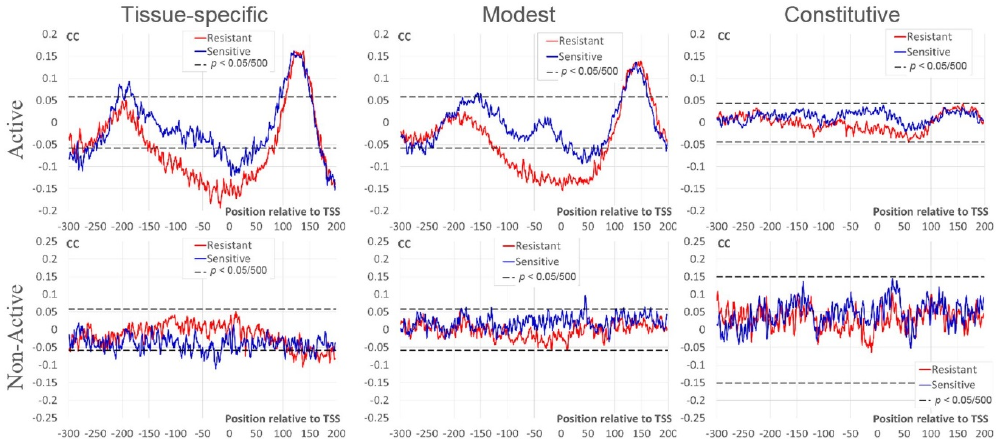
Figure 3. Correlation coefficients (CC) between the expression level (RPKM) and the number of mapped nucleosomes. The top/bottom rows denote datasets of Active/Non-Active genes (see Section 4). The left, middle, and right columns mark intervals of the expression breadth (BoE). X axes show the position relative to TSS, Y axes denote the moving mean of CC over a window of three nt. Red/blue lines denote resistant/sensitive nucleosomes [21]. Dashed black lines mark the threshold of Bonferroni corrected p -value for CC ( p < 0.05/500).